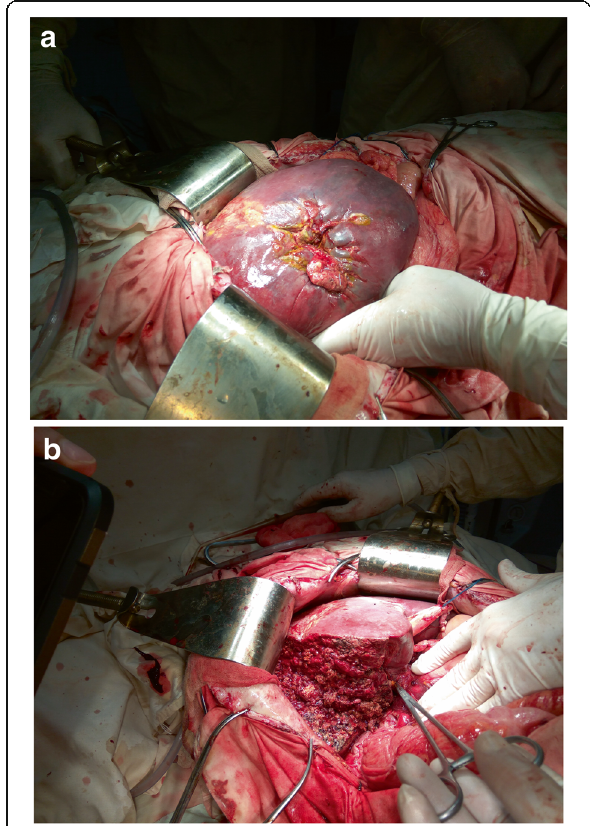
Fig. 5 Intraoperative photograph illustrating liver at relaparatomy on the 16th day after the injury. a Damaged area of liver is covered with fibrin, bile leakage is seen under the partial failure of sutures. b Liver after the resection of fifth and sixth segments